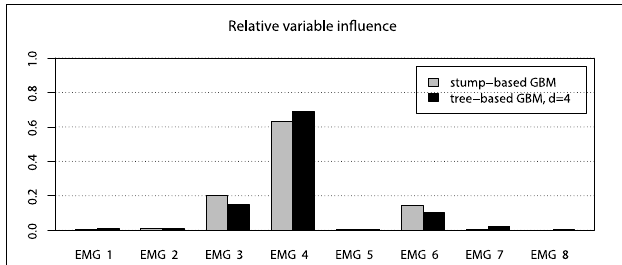
FIGURE 10 | Relative variable influence for tree-based GBMs on the EMG robotic control data.